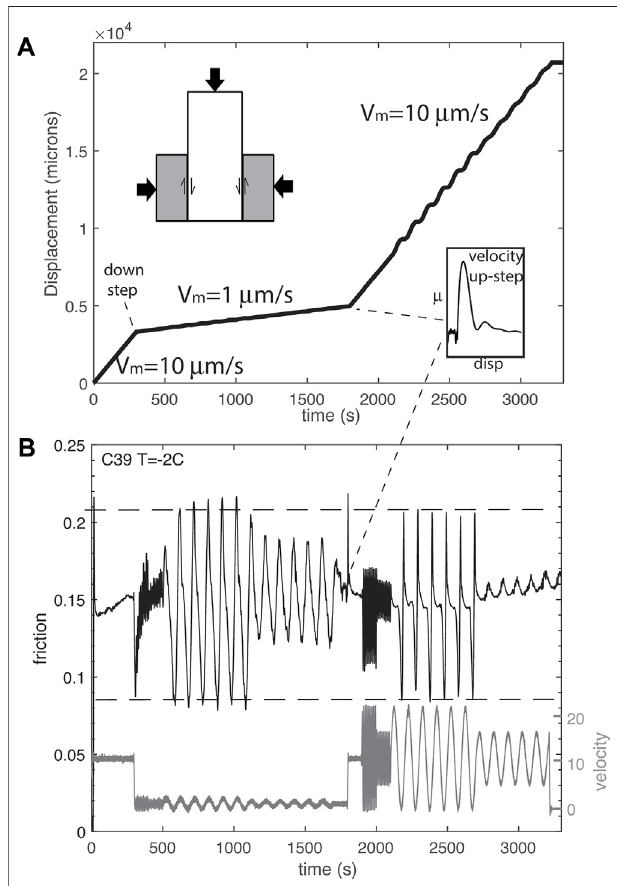
FIGURE 1 | (A) Displacement vs . time showing the driving control program. (B) Driving velocity in gray and measured friction (black) for a single run (C39) of ice sliding on rock in double direct shear (upper inset) at − 2 ° C.